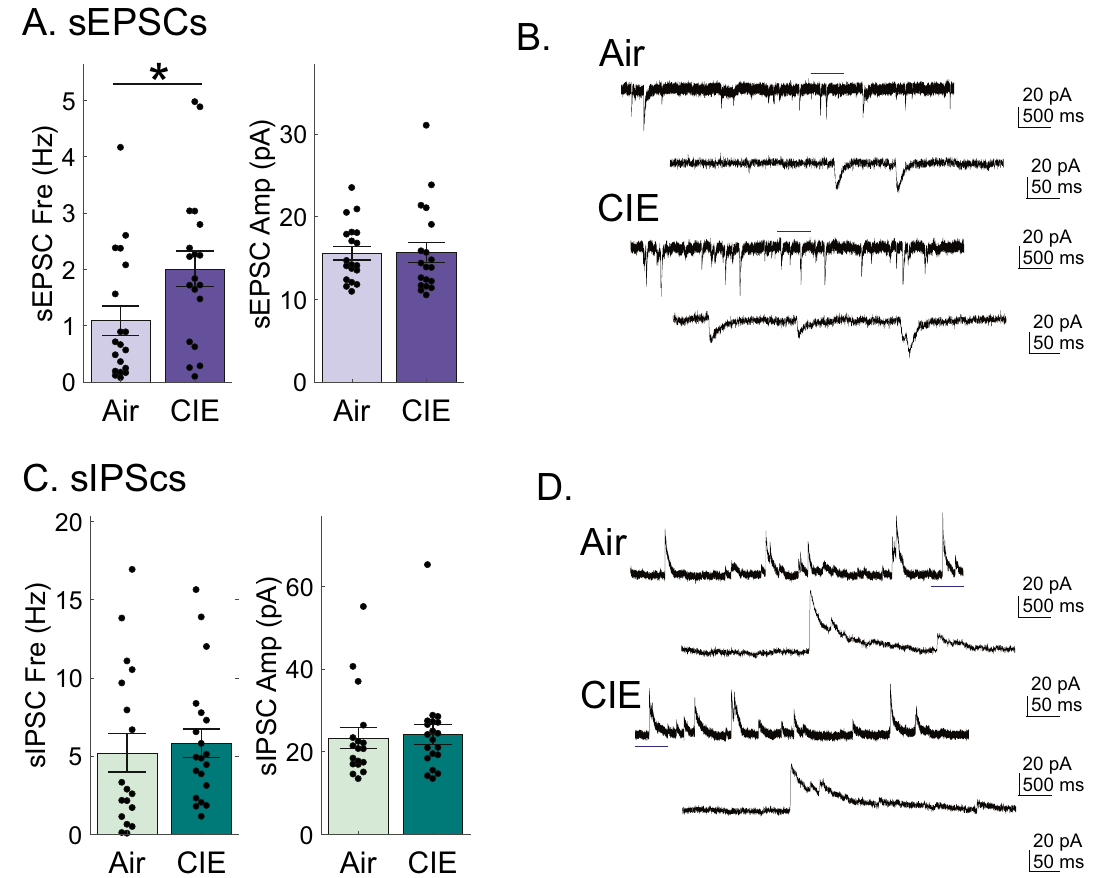
Figure 5. CIE-treated rats show an increase in spontaneous synaptic release of glutamate, but not GABA. ( A ) CIE rats have an increased sEPSC frequency (left graph), but not amplitude (right graph). ( B ) Representative sEPSC traces recorded from vSub neurons of Air (top two traces) and CIE (lower two traces) rats. ( C ) CIE rats do not show a change in frequency (left graph) or amplitude (right graph) of sIPSCs. ( D ) Representative sIPSC traces recorded from vSub neurons of Air (top two traces) and CIE (lower two traces) rats. Blue line above upper traces indicates zoomed in section illustrated in lower traces. *p < 0.05 and errors are reported as ±